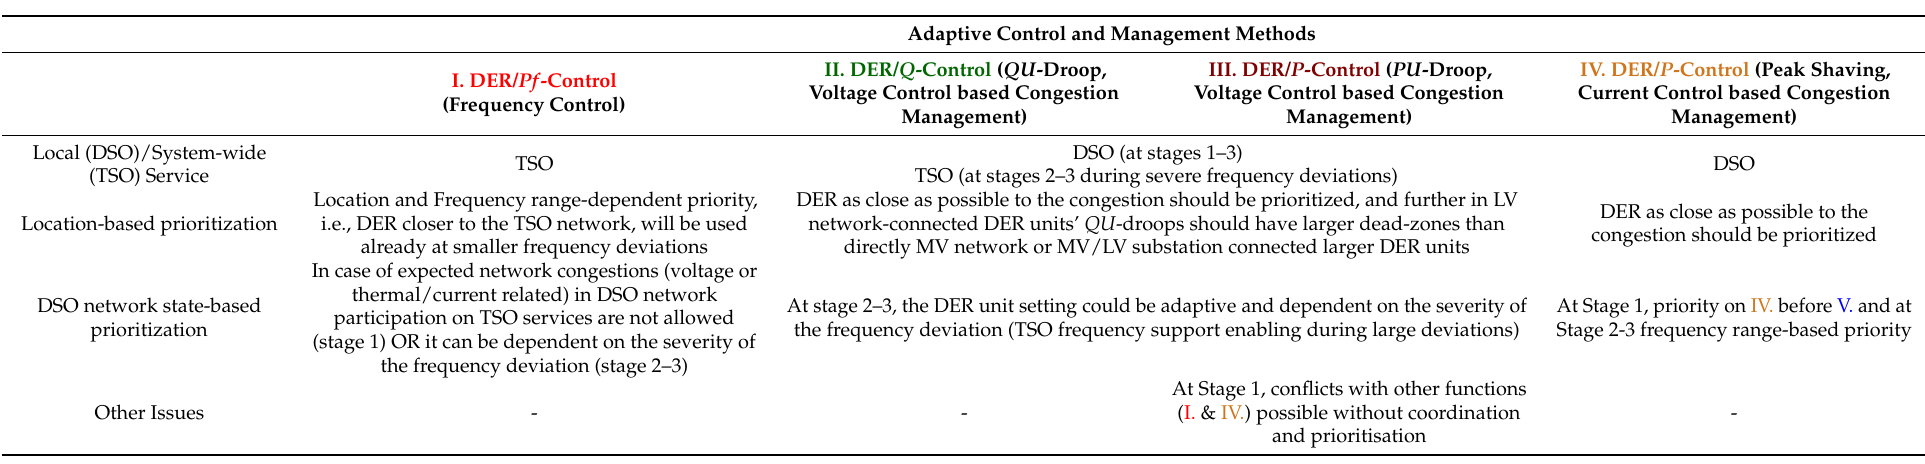
Table 4. Issues related to adaptive control and management methods I.–IV. evolution during different stages 1–3 (see Figure 3, Tables 3 and